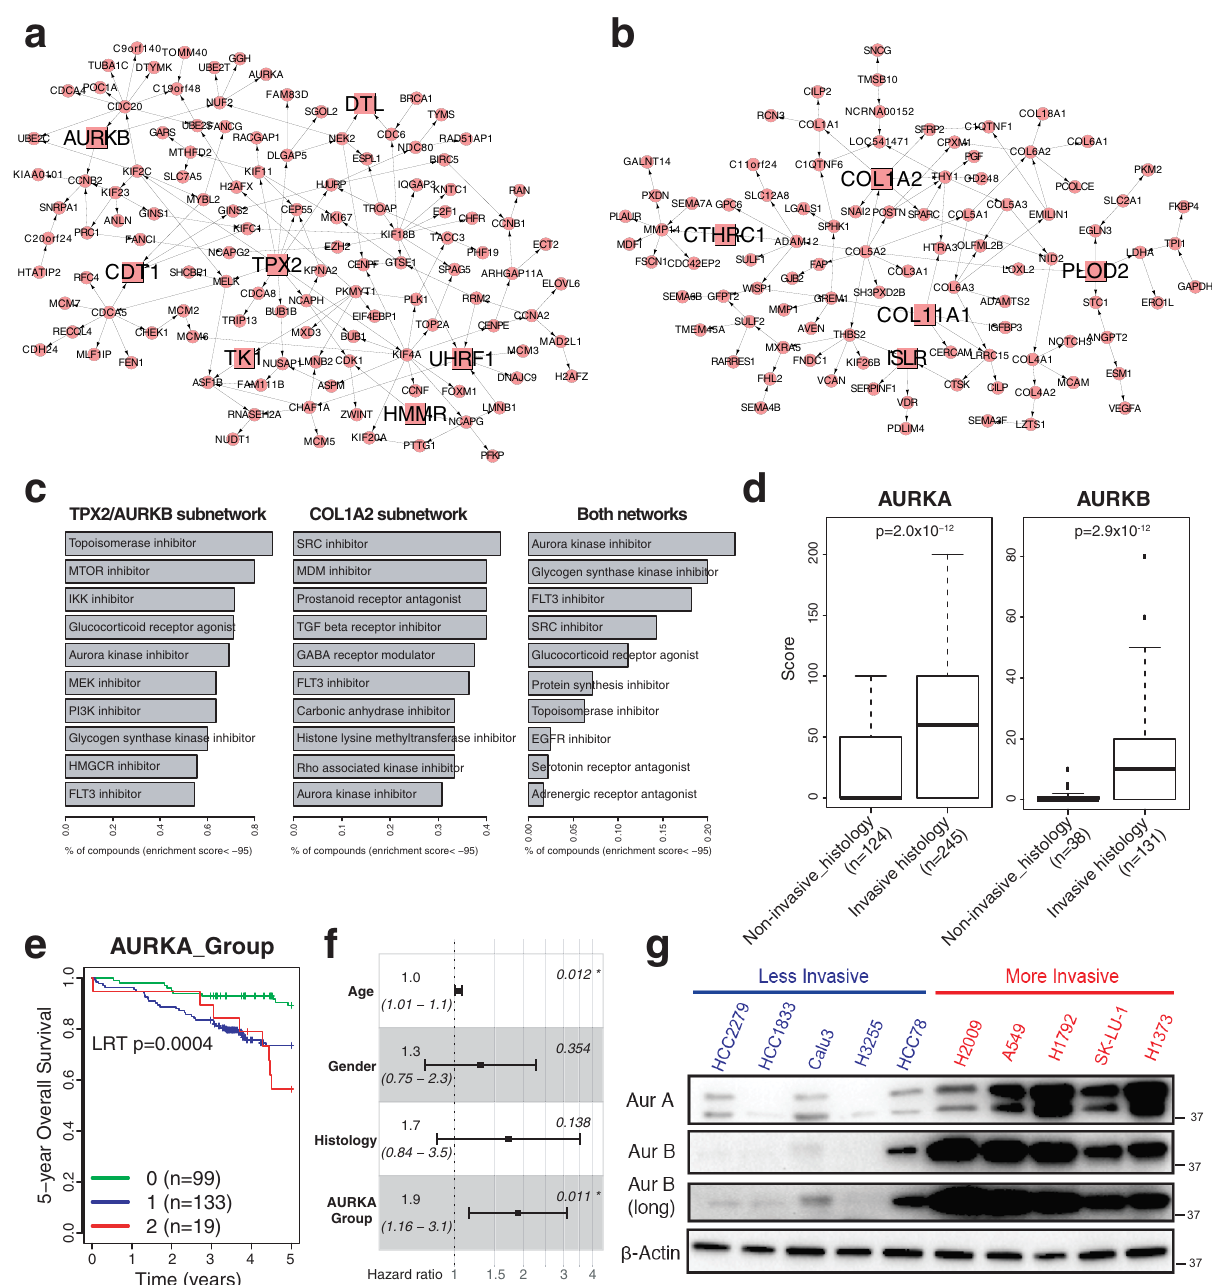
Fig. 3 AURKA and AURKB are putative master regulators regulating pro-invasive signatures. a A subnetwork of 123 pro-invasive genes driven by TPX2 and AURKB . Seven putative master regulators are marked by squares with larger size. Source data are provided in Source Data fi les. b A subnetwork of 97 pro- invasive genes driven by COL1A2 . Five putative master regulators are marked by squares with larger size. Source data are provided in Source Data fi les. c Top 10 small molecular classes signi fi cantly reversing expression of genes in the two subnetworks in A549 using CMAP database (enrichment score< − 95, Methods): left for TPX2/AURKB subnetwork, middle for COL1A2 subnetwork, and right for both. Source data are provided in Source Data fi les. d Comparison of Aurora-A and B protein scores between non-invasive_histology (AIS, MIA, LPA) and invasive_histology (AC, MP, PAP, SOL) tumors from human tissue microarray data. Aurora-B score are not available for all patients. The middle line of the box is median values for each group and the box edges are the 25th and 75th percentiles. Whiskers indicate maximum and minimum values of each group except for outliers. Two-side t -test p -values are shown. Source data are provided in Source Data fi les. e KM curve showing the survival differences between patients classi fi ed into 0, 1, 2 + based on Aurora-A score and the percentage of positive cells (Methods). The LRT p-value is estimated. Source data are provided in Source Data fi les. f Hazard ratios and 95% con fi dence intervals of multiple factors are measured by multivariate cox regression from Survival (cid:1) age þ sex þ histology þ AURKA Group. Center dots indicate Hazard ratios and error bars indicate upper and lower 95% con fi dence intervals. Signi fi cant p -values are marked by asterisk. Source data are provided in Source Data fi les. g Western blot of Aurora-A and Aurora-B for panel of fi ve less invasive and fi ve more invasive LUAD cell lines from Fig. 2i. Source data are provided in Source Data fi